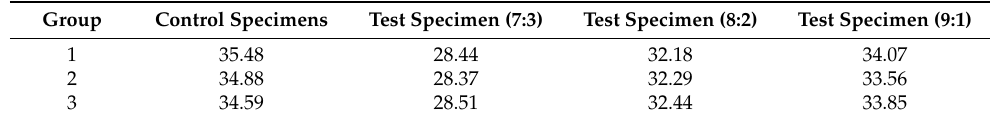
Table 5. Strength of specimens (in MPa) with different